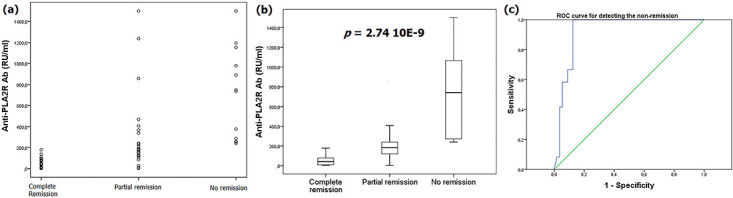
Anti-PLA2R Ab and PMN outcome.(a) Dot plot underlining anti-PLA2R antibody levels in terms of PMN outcome. (b) Box plot highlighting significant higher anti-PLA2R levels in non-remission patients. (c) ROC curve for anti-PLA2R Ab in predicting non-remission: AUC = 92.9% [0.869–0.989], p = 3.46 10E-6; Cut-off = 372.1 RU/ml, specificity = 91.1%, sensitivity = 66.7%.